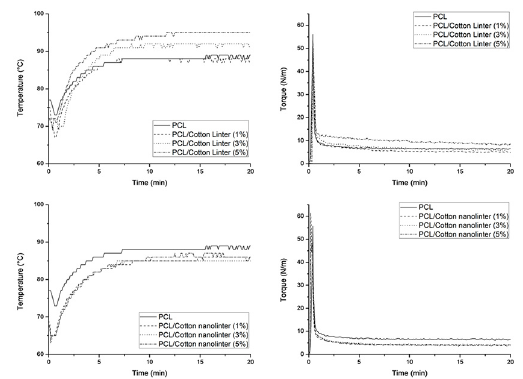
Figure 3: Temperature (left: a and c) and torque (right: b and d) versus time for PCL/cotton linter and PCL/cotton nanolinter compounds. Compositions indicated.